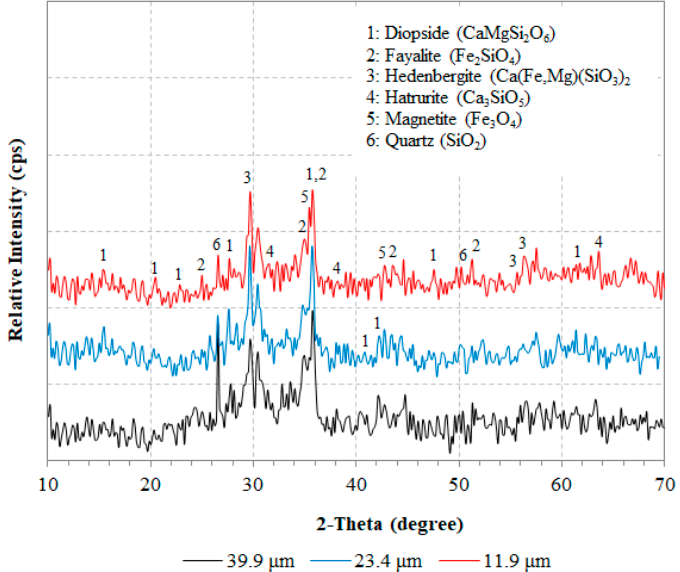
Figure 12. XRD patterns of produced AAMs when di ff erent median sizes of slag particles were used. Synthesis conditions were: molar ratio in the reactive paste H 2 O / Na 2 O 12.9, curing temperature 80 ◦ C, curing time 24 h, ageing period seven days.